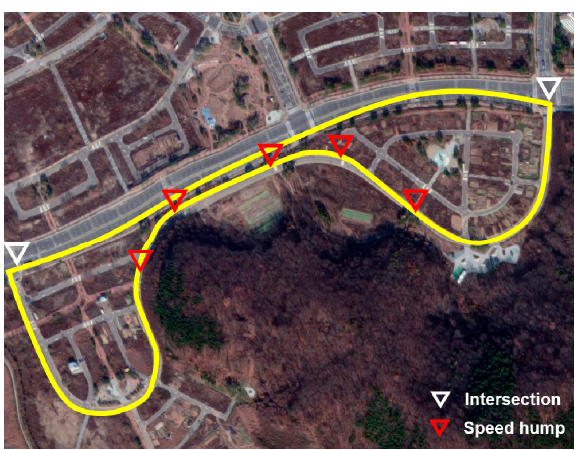
Figure 13. Driving route for driving simulation data acquisition.